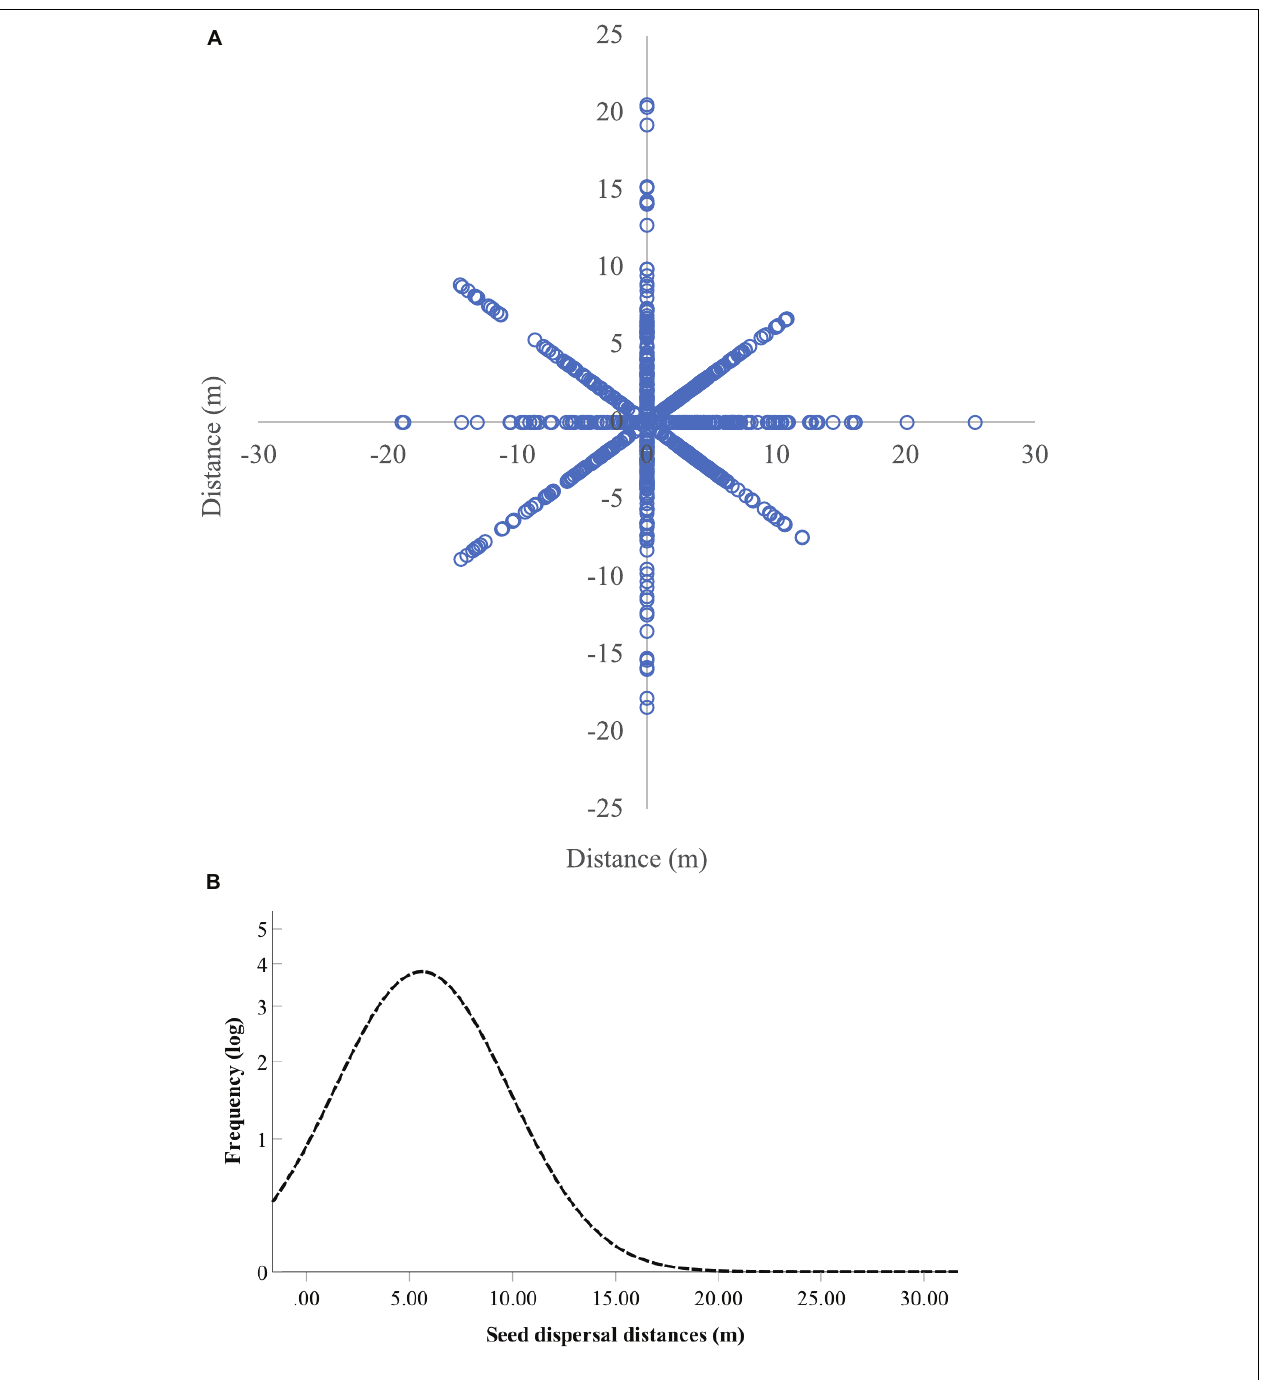
FIGURE 5 | The spatial distribution pattern (A) and frequency distribution curve of observed dispersal distances (B) of Quercus variabilis seedlings in the field. In total, 811 seedlings were surveyed, in which 234 seedlings showed δ 15 N values higher than the natural ones.